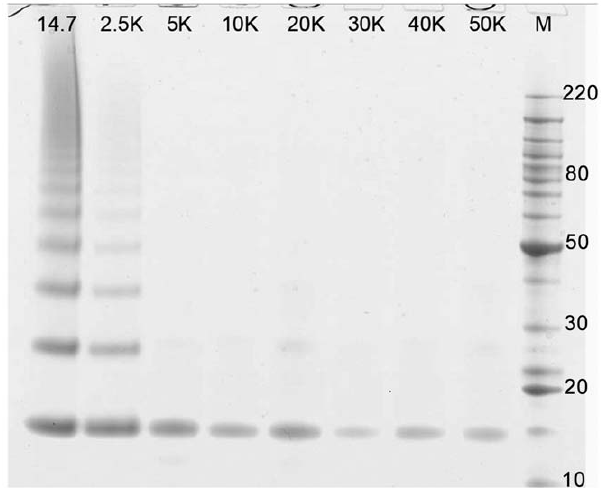
Figure 4. Effect of elevated pressure on the rate of cross-link reversal. Percent monomeric protein recovered. 1 mg/ml solutions of RNase A was incubated in 10% phosphate buffered formalin for one hour, and the excess formaldehyde solution was exchanged for 1 6 TAE buffer, pH 4. The aqueous fixed RNase A solution consisted of 18 percent monomeric and 82 percent multimeric protein by 1-D SDS- PAGE. Aliquots of the formalin fixed solution were incubated at 14.7– 40,000 psi for 3.5 hours at either 55 u C (squares) or 65 u C (triangles). The heat-treaed samples were separated by SDS-PAGE and the gel bands were integrated to determine the percentage of monomeric protein at each pressure. doi:10.1371/journal.pone.0014253.g004 number of broad, late eluting peaks, suggesting that the material panel C). There were only a total of 5 correctly identified spectra,